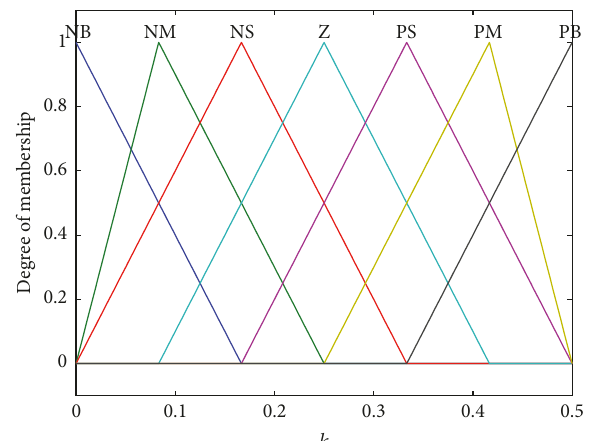
Figure 9: Outputs of the 𝑘 membership function curve.